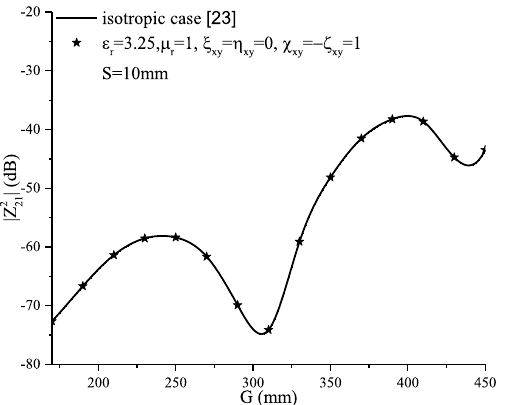
Figure 15. Mutual coupling of an echelon configuration with non-reciprocal bianisotropic Tellegen medium ς ( χ xy xy ). = −